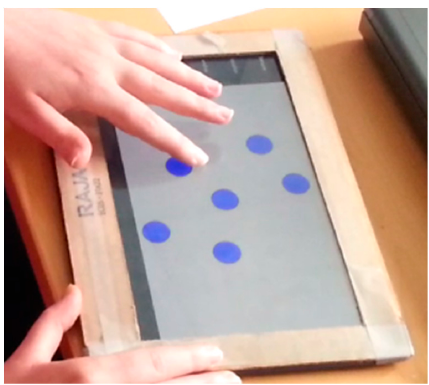
Figure 1. Photograph of the tablet computer. Cardboard served as physical landmark to delimitate the screen space and to protect buttons from unintended touches.